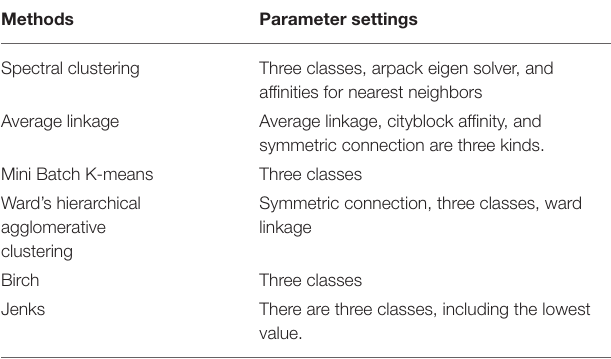
TABLE 2 | Clustering technique’s parameter